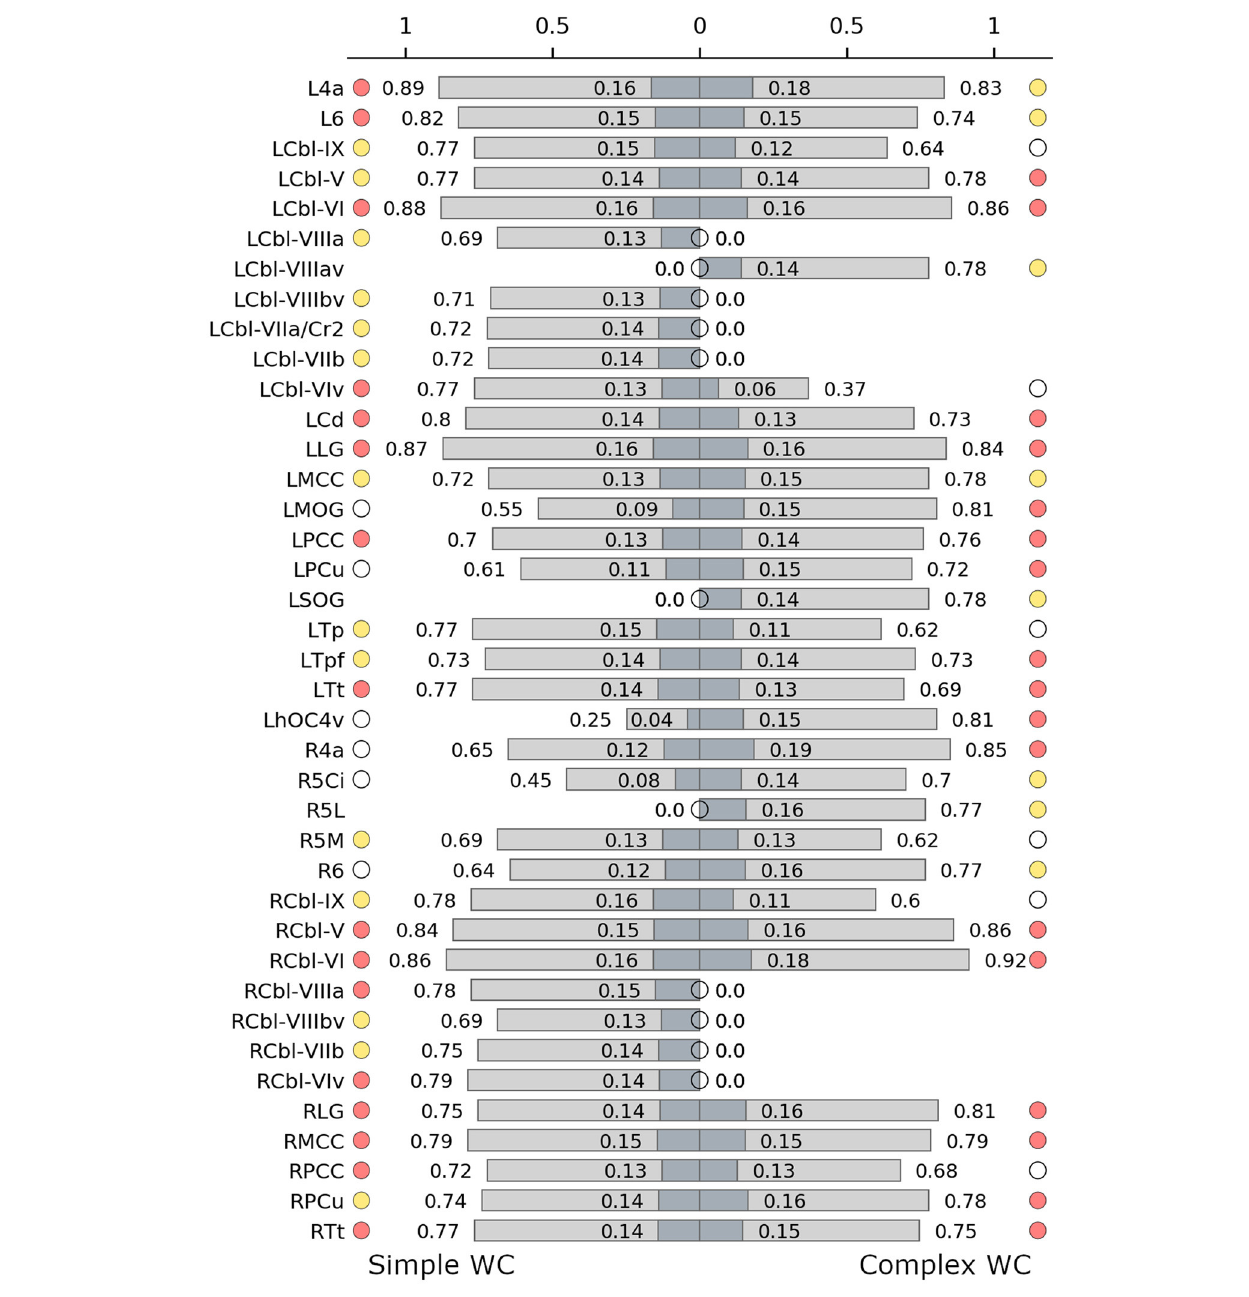
FIGURE 4 | Hub characteristics of the simple (left) and complex (right) writer’s cramp networks. The graph shows all nodes that were recruited as hubs in either of the two networks. For each hub, normalized nodal degree (light grey) and normalized nodal strength (dark grey) are indicated by bars. White circles denote nodes that were not hubs in the respective network, absence of circles denotes that the node was not present in the respective network. Red circles denote connector hubs, yellow circles denote provincial hubs. 6, BA 6; 4a, anterior part of BA 4; 5Ci/5L/5M, subdivisions of BA 5; Cbl V/VI/VIv/VIIaCr2/VIIb/VIIIa/VIIIav/VIIIbv/IX, cerebellar lobules V/VI/VI vermis/VIIa crus II/VIIb/VIIIa/VIIIa vermis/VIIIb vermis/IX; Cd, caudate nucleus; hOC4v, ventral part of area hOC4; LG, lingual gyrus; MCC/PCC, middle/posterior cingulate cortex; MOG, middle occipital gyrus; PCu, precuneus; SOG, superior orbital gyrus; Tp/Tpf/Tt, parietal/prefrontal/temporal/ subdivision of the thalamus; L, left; R,